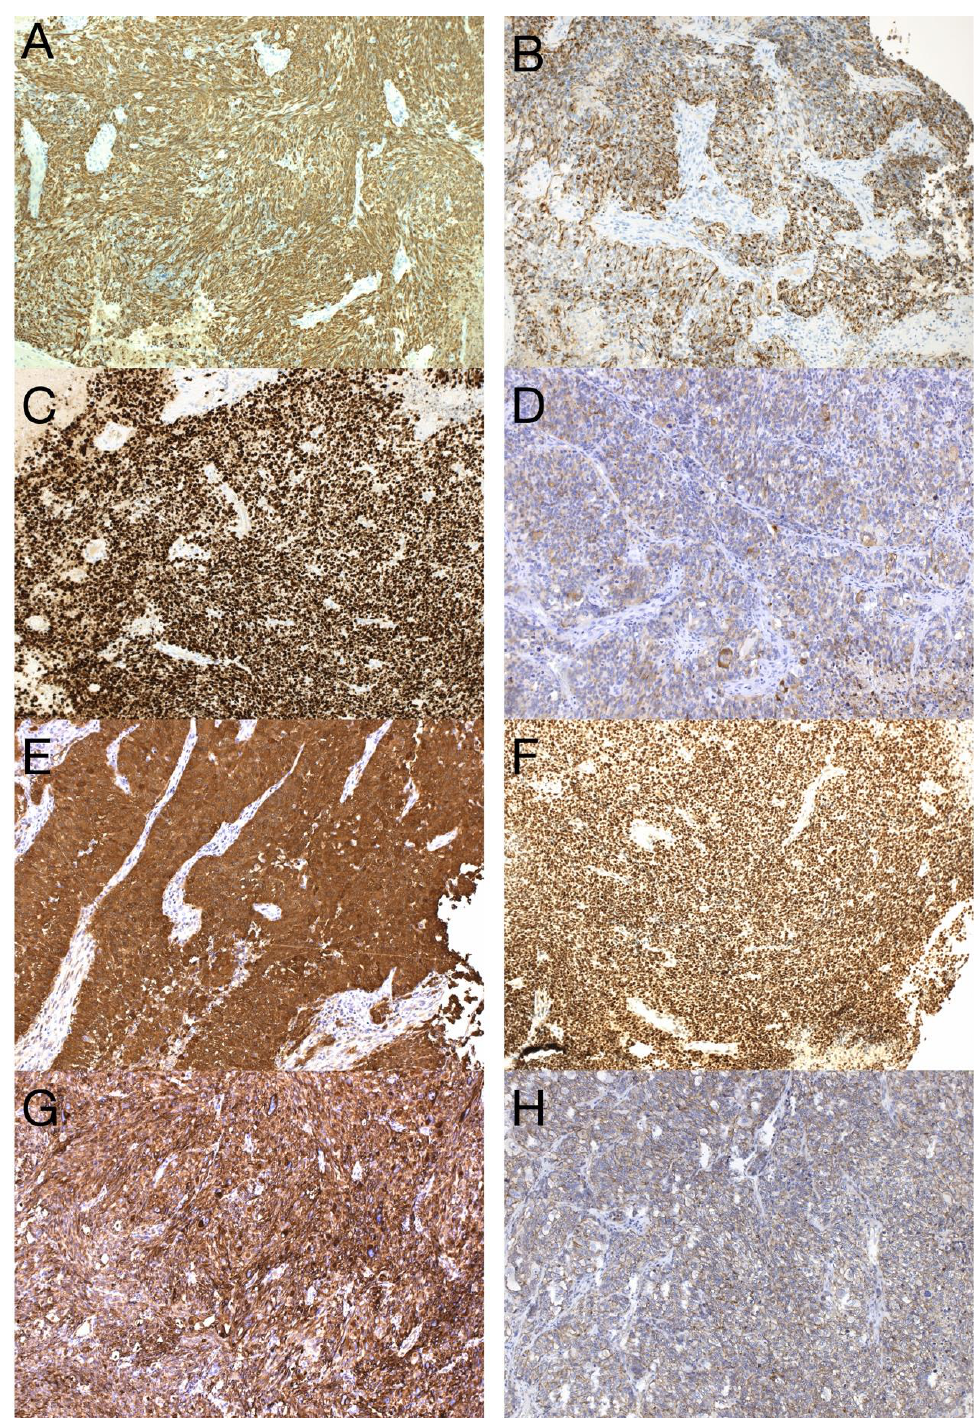
Figure 3. Immunohistochemical analysis of the primary tumor — GBM PNC, IDH wildtype. Immunohistochemical expression of GFAP in tumor cells ( A ), which was reduced in foci with PNC morphology ( B ). The proliferation index Ki-67 in hotspots morphologically corresponding to PNC reached up to 99% ( C ). In regions with PNC morphology, the expression of synaptophysin was detected immunohistochemically ( D ). The expression of neuron-specific enolase was observed throughout the tumor ( E ), as well as intense nuclear immunopositivity for p53 ( F ). GBM tumor cells displayed diffuse and strong expression of nestin ( G ). Beta-catenin expression was limited to the membrane, lacking nuclear expression ( H ) (original magnification 100×).